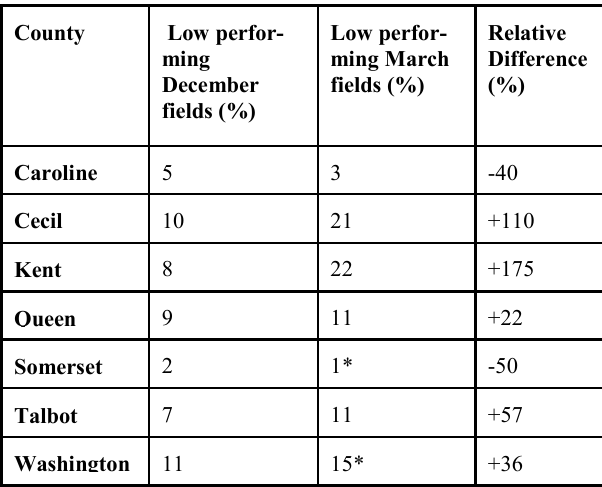
Table 3. Percentages of low performing (below 0.3 NDVI) fields for various Maryland counties in winter and